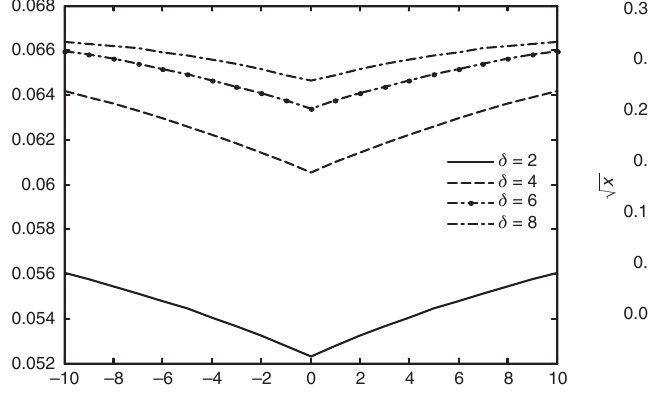
when impedance parameters δ 0